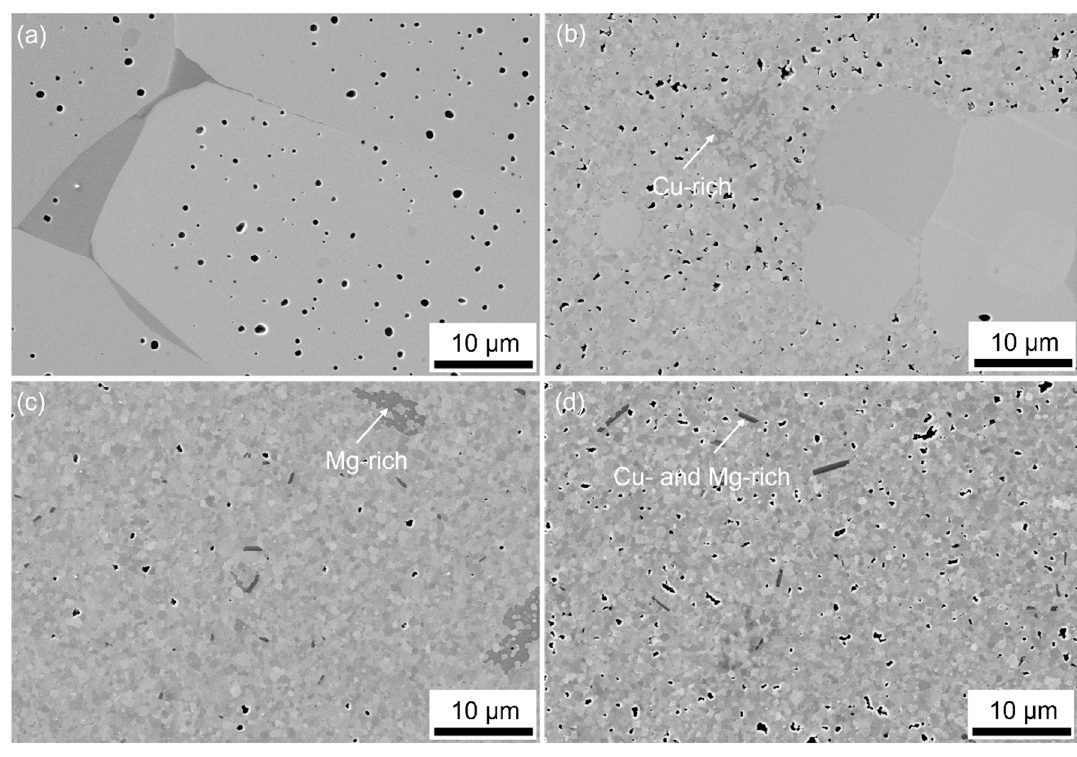
Figure 2. FESEM images of BSSnT-18-6.5 ( a ), BSSnT-Cu ( b ), BSSnT-Mg ( c ) and BSSnT-Cu-Mg ( d ).